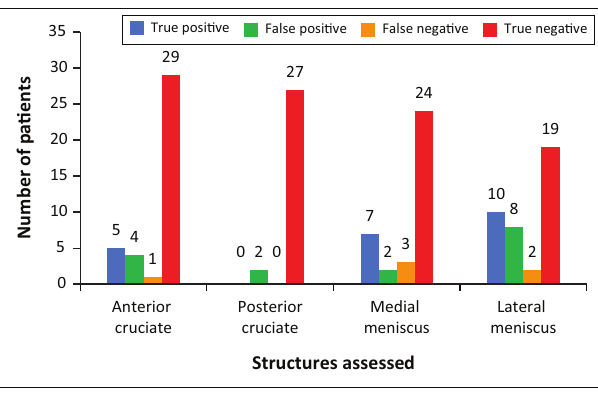
FIGURE 1: Comparison between magnetic resonance imaging and arthroscopic findings–tear versus intact ligament.